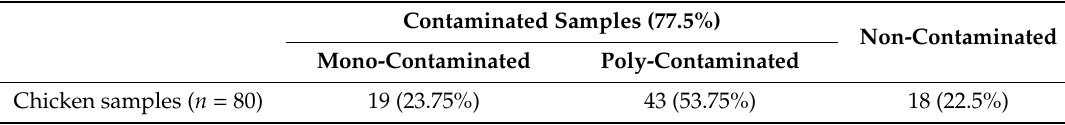
Table 3. Occurrence of antibiotic residues in chicken meat